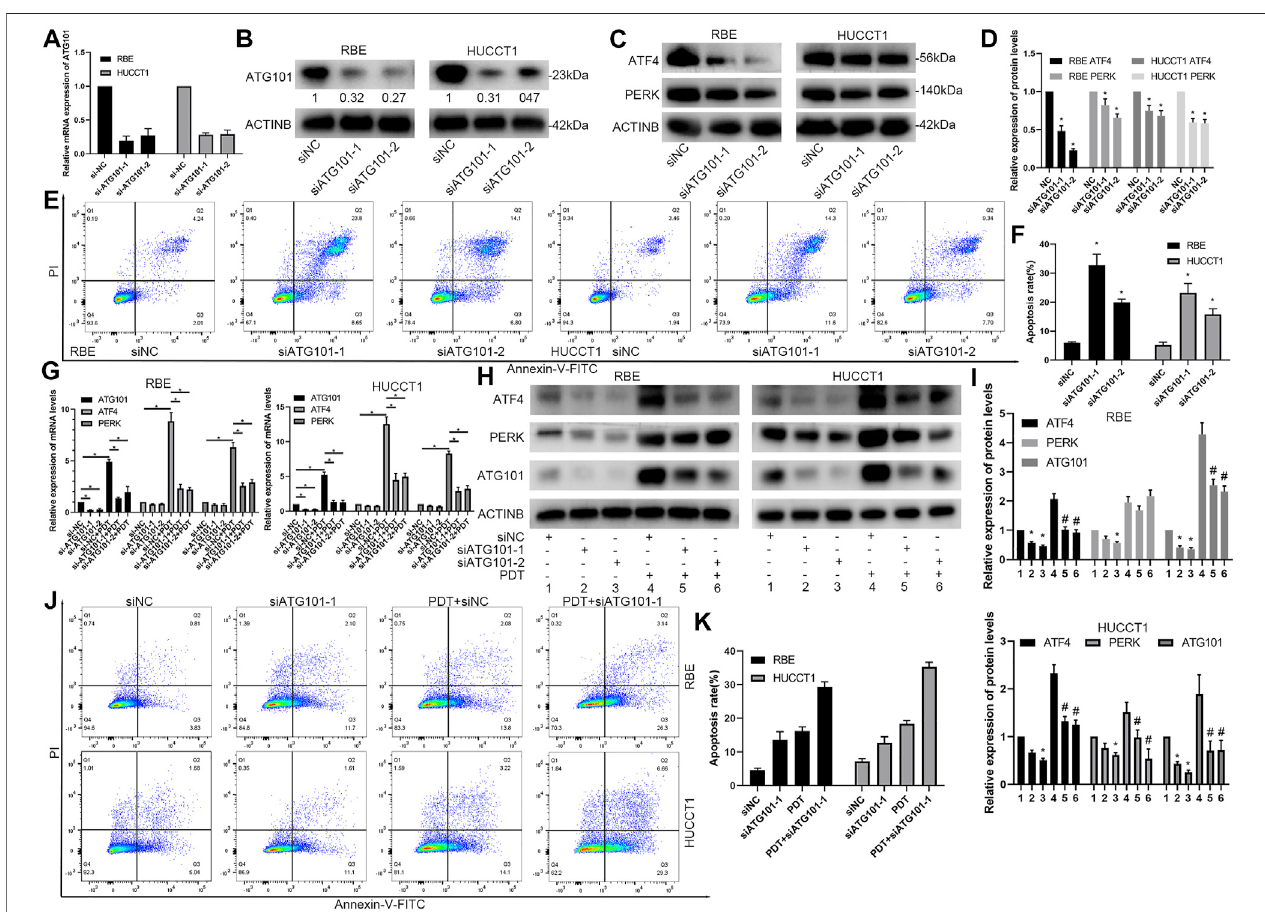
FIGURE 9 | Downregulation of ATG101 inhibits the expression of unfolded protein response markers and promotes PDT-induced apoptosis of cholangiocarcinoma cells. (A,B) ATG101 was depleted by speci fi c siRNA (siATG101-1, siATG101-2) in RBE and HUCCT1 cell lines and con fi rmed by qRT-PCR(A) or Western blot(B). (C) ATG101 was depleted by speci fi c siRNA in RBE and HUCCT1 cell lines and protein levels of ATF4, PERK were con fi rmed by western blot. (D) is a histogram of the relative expression levels of proteins in each group in (C) . (E) Different siRNAs (siNC, siATG101-1, siATG101-2) were transfected with RBE and HUCCT1 cells in a 6-well plate for 48 h, and then the level of apoptosis was detected by Annexin-V-FITC/PI staining and fl ow cytometry. (F) is a histogram of the total apoptosisrateofeachgroupin (E) . (G,H) ComparisonofeffectonATF4,PERKandATG101byqRT-PCRandwesternblotindifferentsiRNAsgroups(siNC,siATG101- 1, siATG101-2) which were transfected with RBE and HUCCT1 cell lines for 40 h with or without PYRO-PDT (100 Nm, 10 J/cm 2 ). (I) is a histogram of the relative expression of proteins in each group in (H). * Compared with group 1; # compared with group 4. (J) Annexin-V-FITC/PI staining and fl ow cytometry was used to